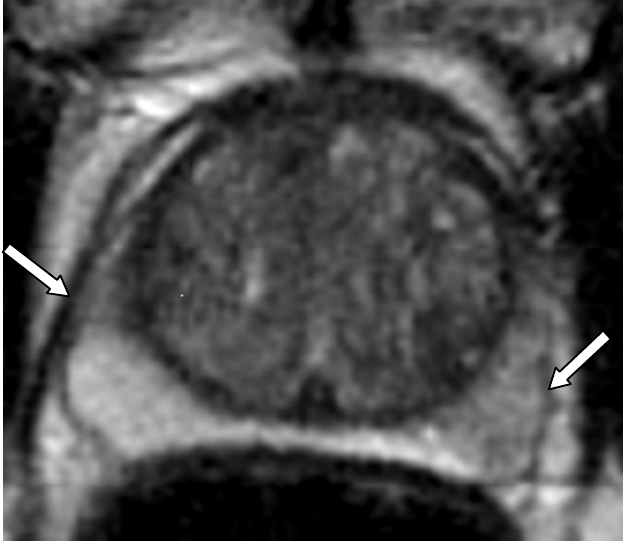
FIGURE 1. Axial T2-weighted MRI of the prostate with endorectal coil. Arrows indicate regions positive for prostate adenocarcinoma on biopsy. (Courtesy of Doug Pendsé, MD, Hashim Uddim Ahmed, MD, and Mark Emberton,